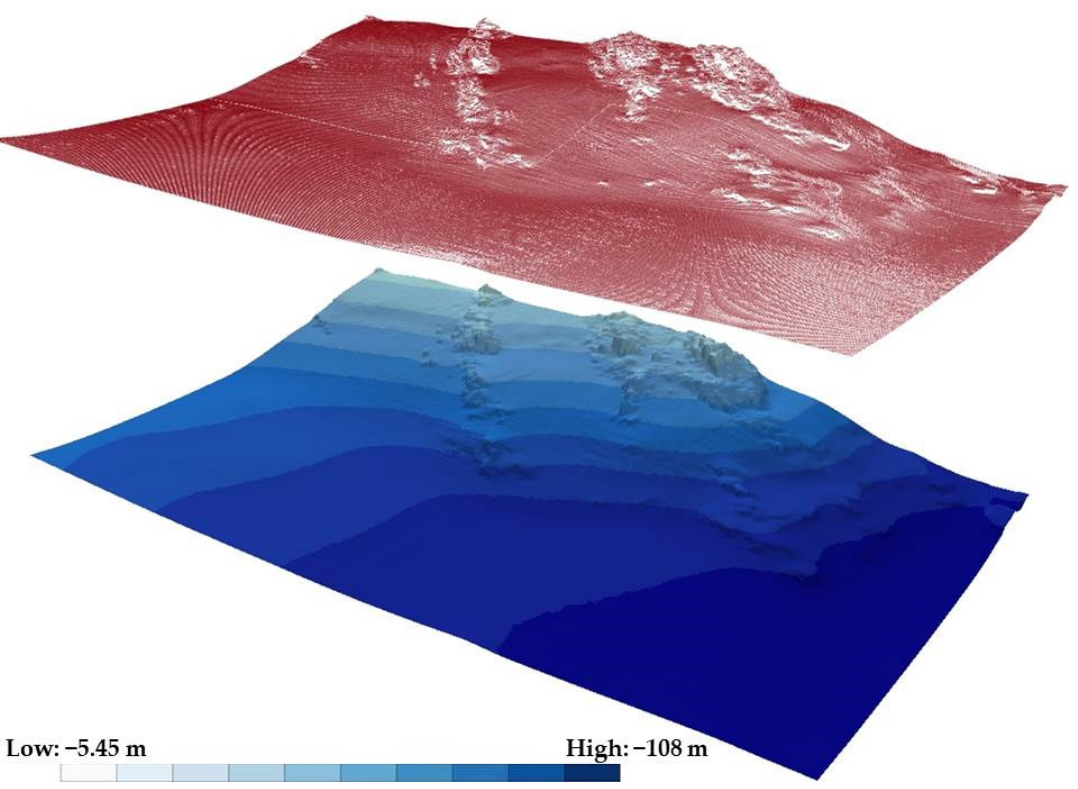
Figure 1. Three-dimensional representation of the seafloor obtained from the entire multi-beam dataset (MBD): the upper image represents the point cloud of the initial MBD; the lower image represents the continuous 3D model of the seafloor.